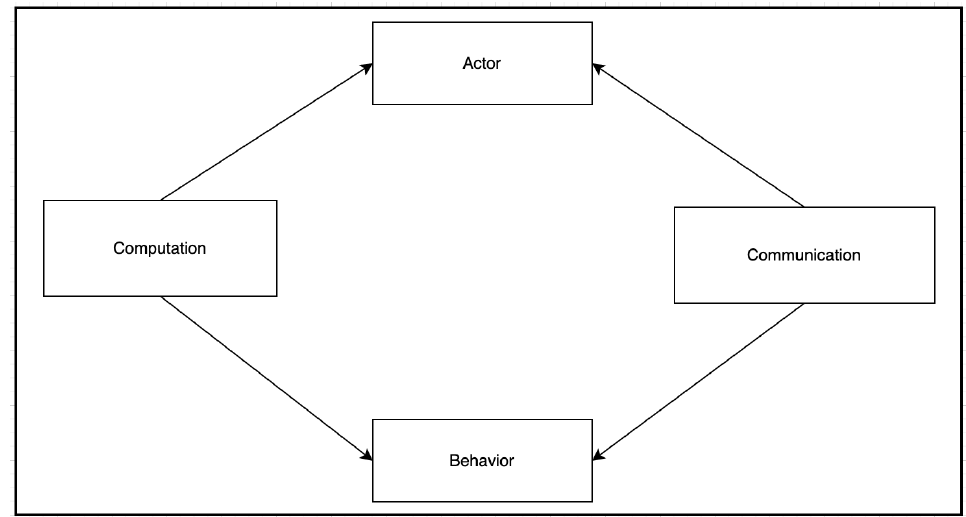
Figure 9. Class Diagram.